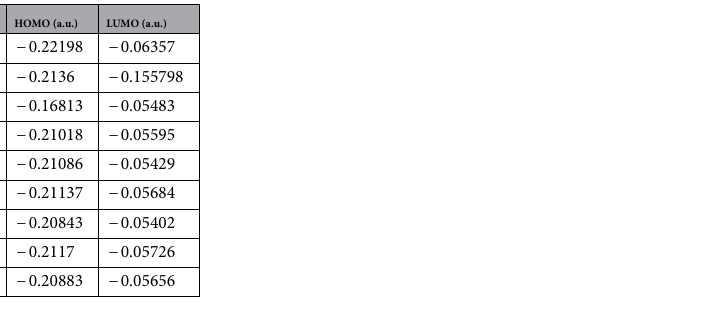
Table 2. Gibbs free